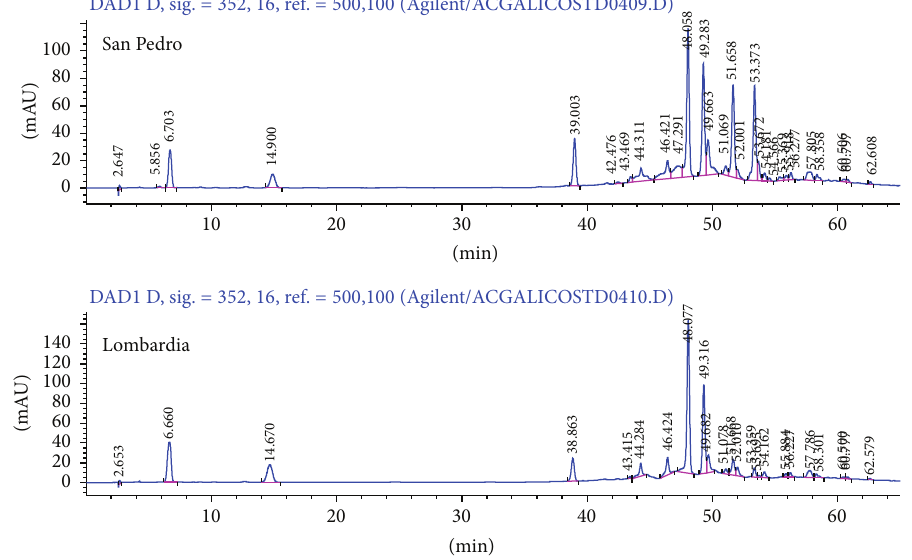
Figure 2: Comparison of gradient HPLC analyses of two varieties of M. oleifera flavonols. Detection was performed at 352